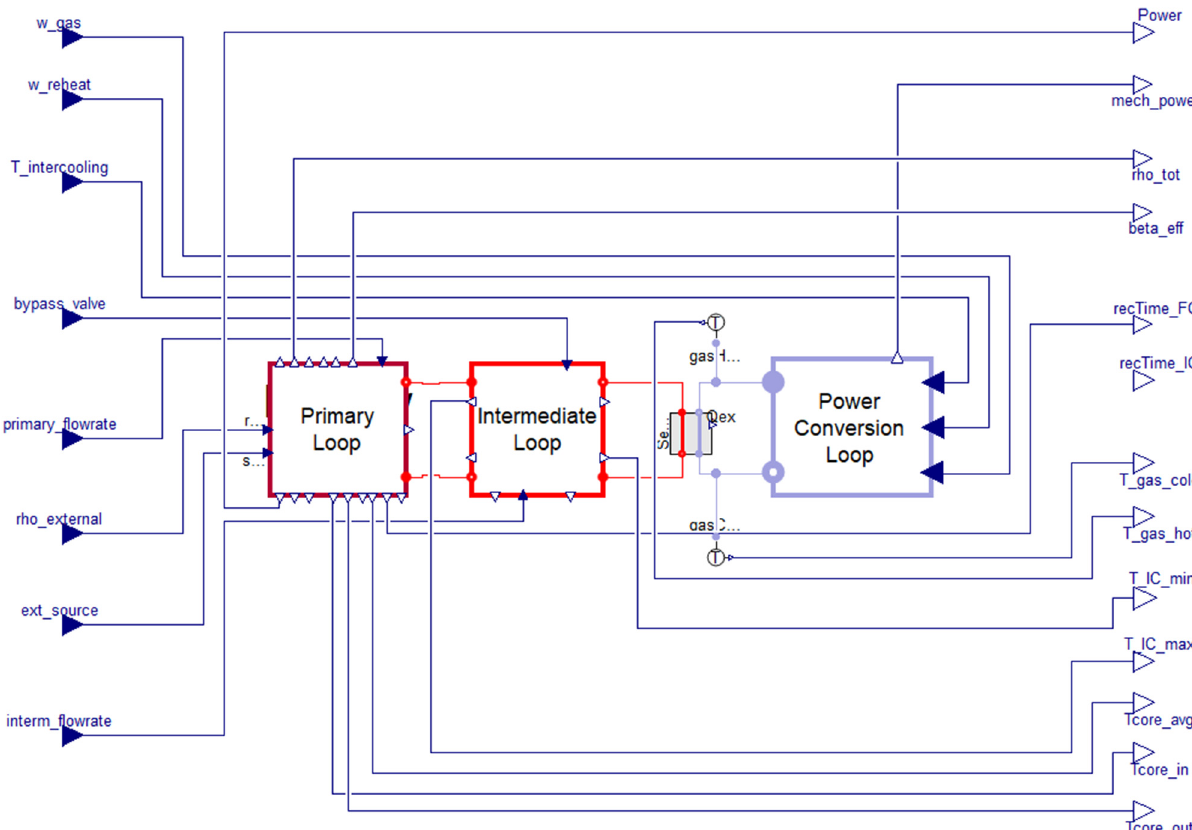
Fig. 10. Object-oriented Dymola model of the coupled plant